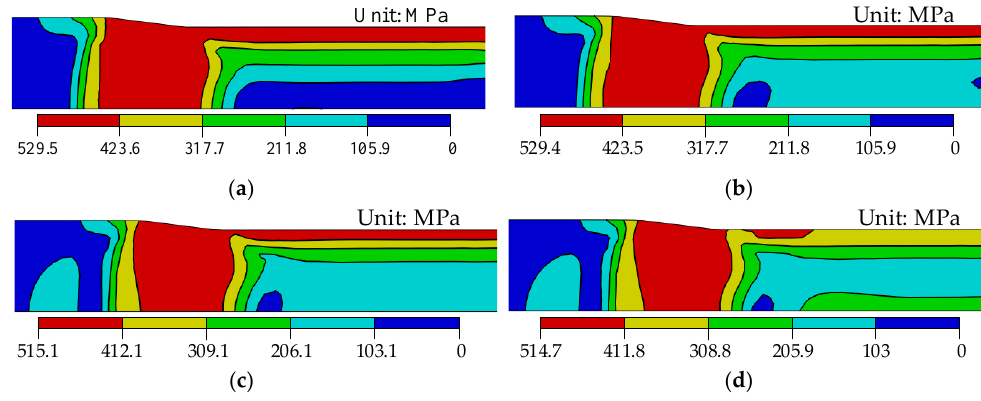
Figure 14. Mises equivalent stress distribution of the wire at the contact region under ultrasonic drawing conditions when the die locates 15.8 mm from the reel and in various motion states: ( a ) Equilibrium position and moves to left; ( b ) Left extreme position; ( c ) Equilibrium position and moves to the right; ( d ) Right extreme position.